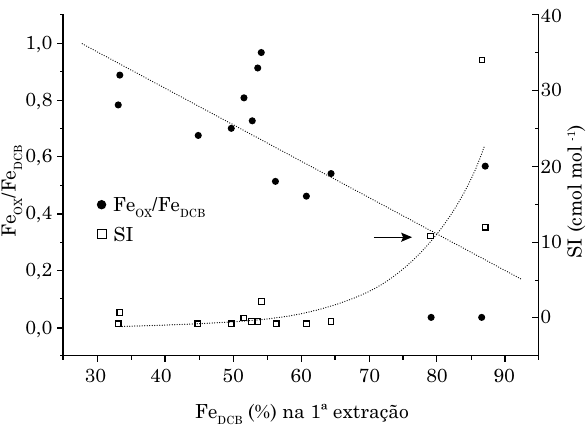
Figura 3. relação entre os teores de Fe 2 O 3 removidos na primeira extração por ditionito-citrato-bicarbonato (DCb) na terra fina seca ao ar e seus respectivos valores da relação Fe OX /Fe DCb e susbtituição isomorfica de Fe por al nos óxidos de Fe (obtida na fração argila) dos horizontes ba e bt 3 dos argissolos Vermelhos e Amarelos, do fragipã do perfil PA 3 e do horizonte espódico do perfil ES